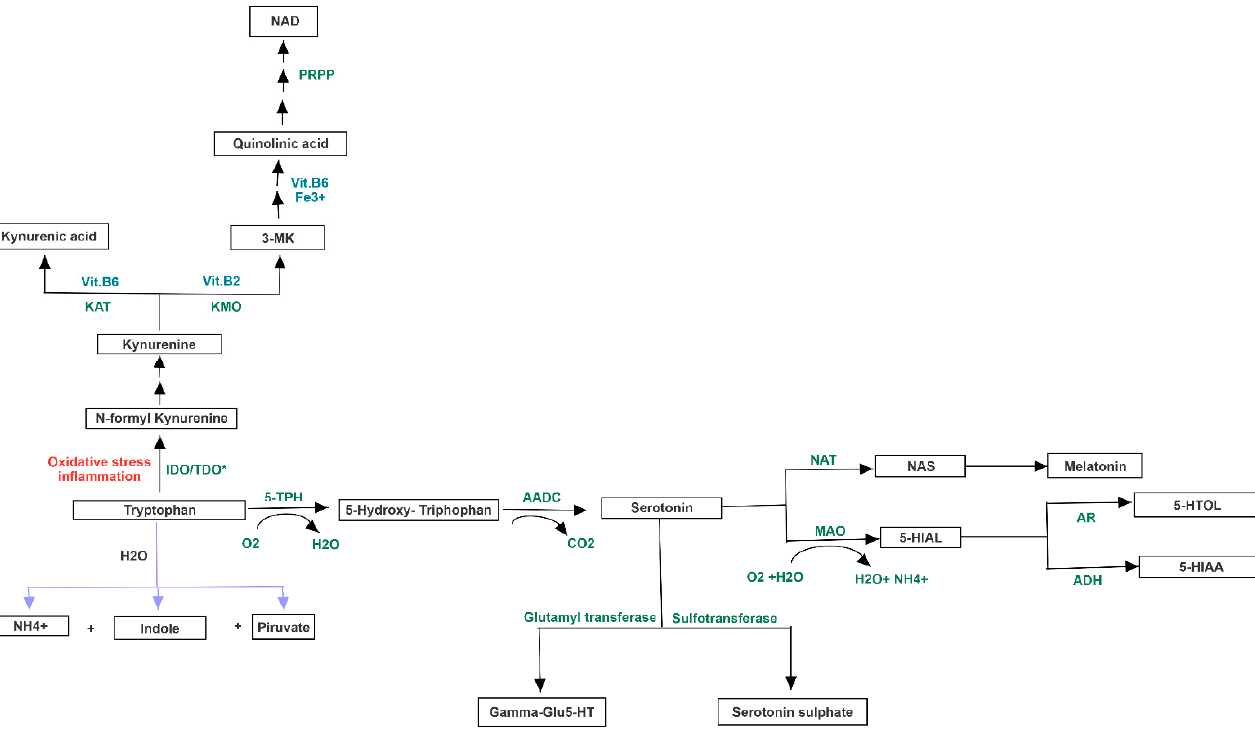
Figure 3. Serotonin metabolism and its “shunt” following oxidative stress and inflammation. Serotonin, produced from tryptophan, could be converted in melatonin. In condition of oxidative stress and inflammation, the amino acid shifts to kynurenine and quinolinic acid pathway, exerting neurotoxic